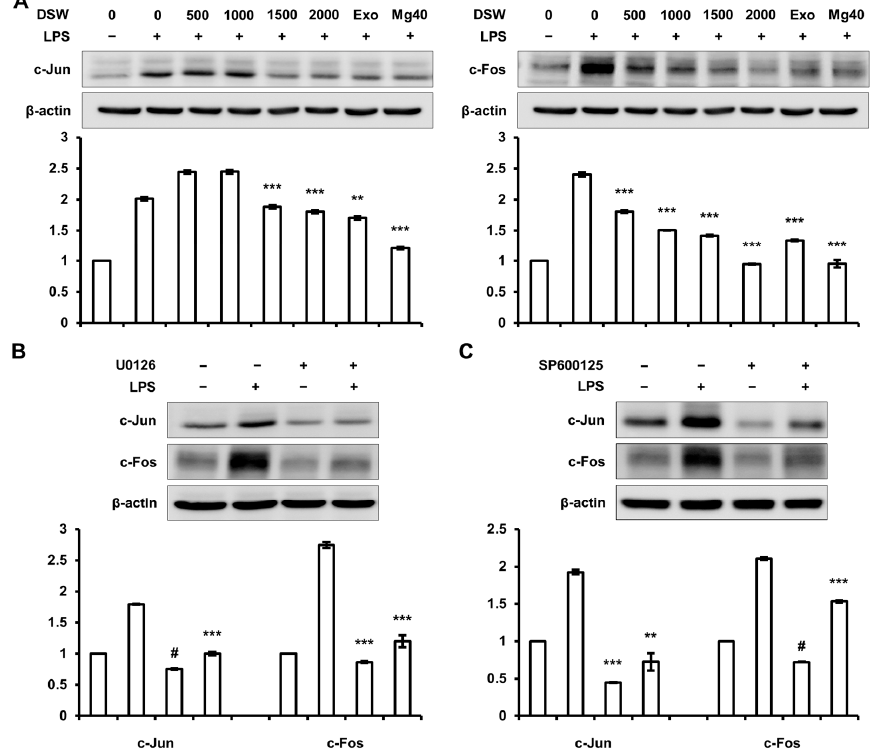
Figure 6. Inhibitory effects of RDSW on LPS-induced inflammatory responses were mediated through the inhibition of the ERK 1/2 and JNK 1/2 signaling pathways. The inhibitory effects of RDSW on LPS-induced ( A ) c-Jun and c-Fos expressions. The involvements of ERK 1/2 and JNK 1/2 signaling pathways in LPS-induced inflammatory response were confirmed by blocking each pathway with a specific inhibitor. The effects of ( B ) 10 µM U0126 (a MEK 1/2 inhibitor) or ( C ) 10 µM SP600125 (a JNK inhibitor) on the expressions of c-Jun and c-Fos in LPS-treated RAW 264.7 macrophage cells. The cells were pre-treated with RDSW for 22 h, and then treated with 10 µM U0126 (a MEK 1/2 inhibitor) or 10 µM SP600125 (a JNK inhibitor) for 2 h prior to LPS stimulation for 1 h. Band density of each sample was normalized with β -actin. All experiments were performed in triplicates, and all data are shown as the mean ± SD. ** p < 0.01, *** p < 0.001 and # p < 0.0001 compared to the LPS-induced control. Exo: hardness 1500 of exogenous Mg and Ca mixture, Mg:Ca = 3.5:1; Mg40: hardness 1500 of high Mg DSW, Mg:Ca =